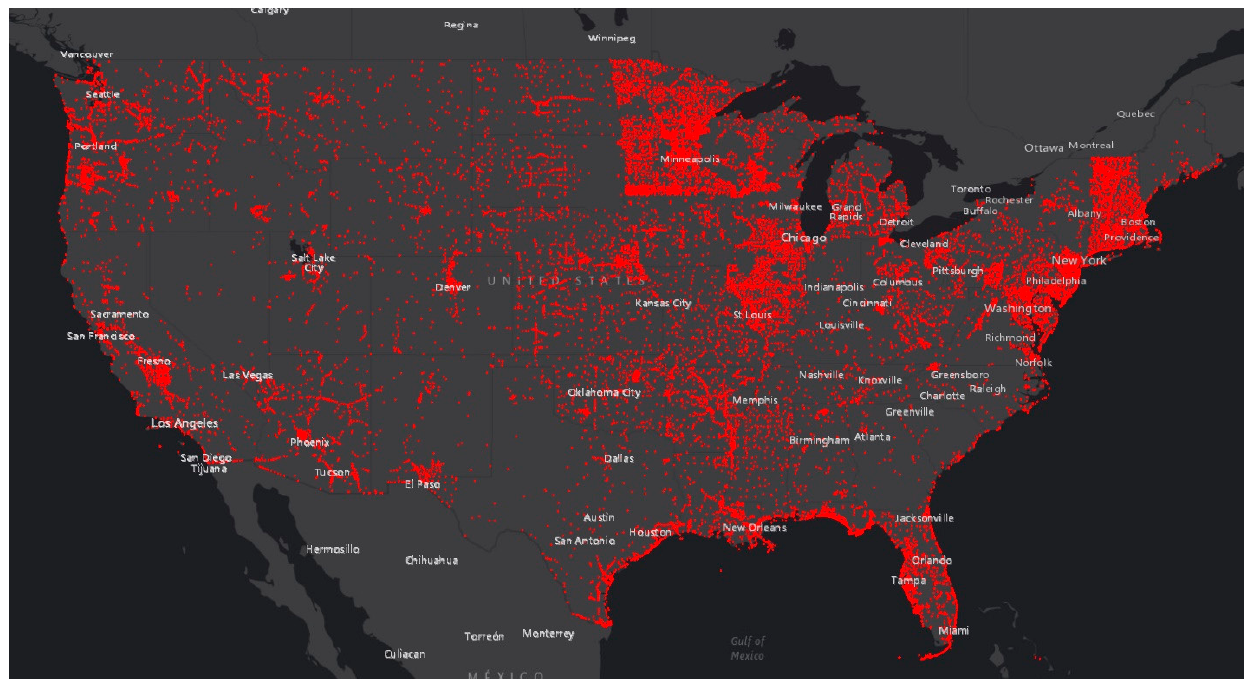
Figure 3. Locations of 3DEP lidar checkpoints ( n = 50,486).